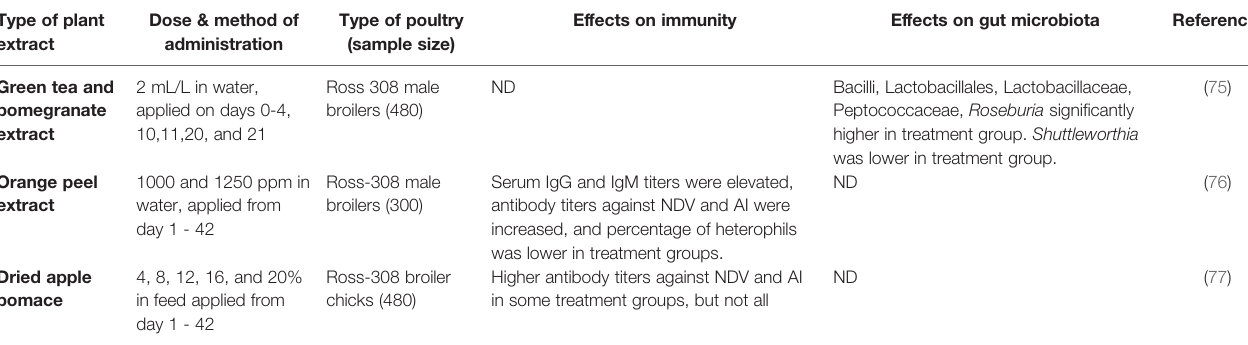
TABLE 5 | A comparison of in vivo feeding studies of various other fruit byproducts and extracts in poultry, highlighting signi fi cant effects on the immune system and gut microbiota in live